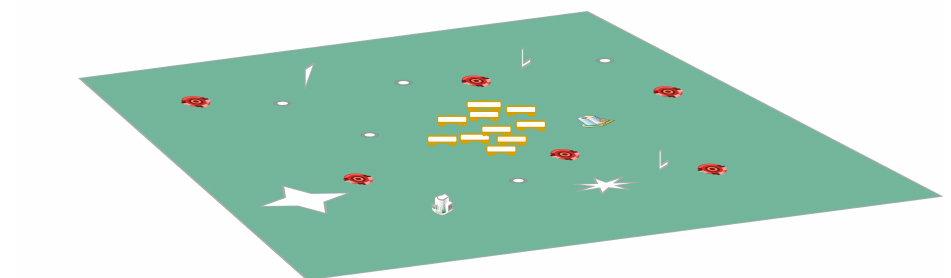
Figure 2. Example of initial setup with 10 robots at a drop-off point to be deployed in the task environment.